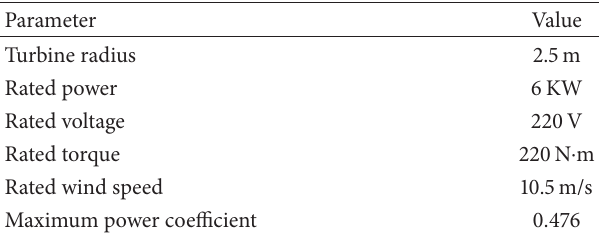
Table 1: Wind turbine parameter